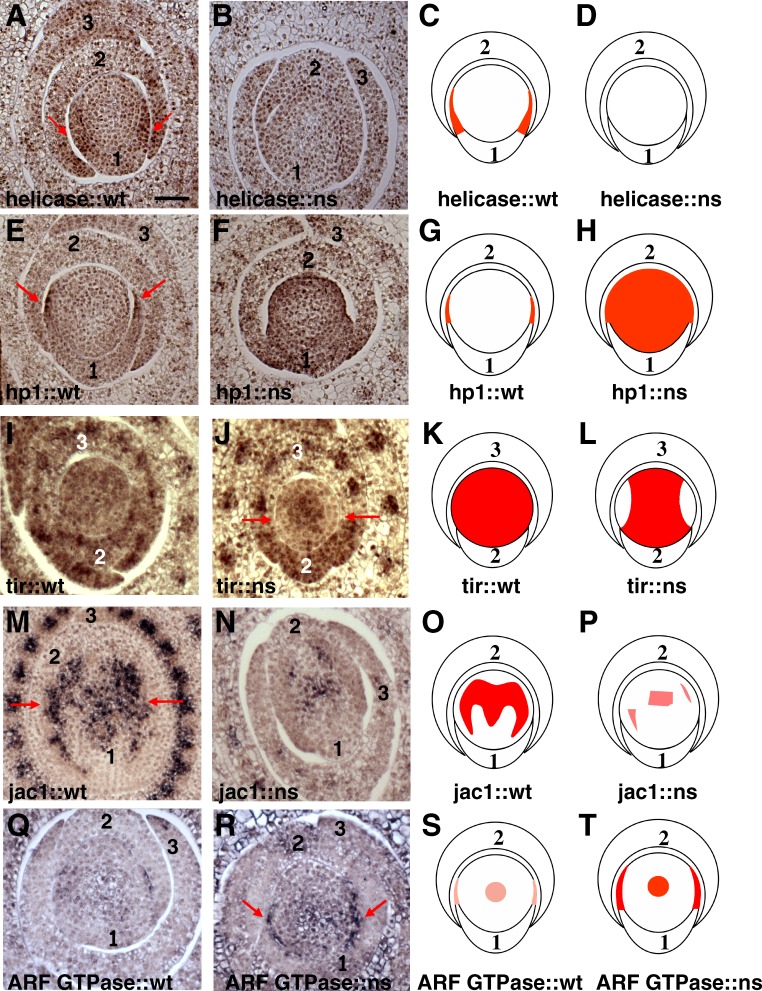
In Situ Hybridization Reveals Domain-Specific Expression of Differentially Expressed Maize Genes in Nonmutant and ns1-R Mutant Shoot Apices, Part I.Drawings of SAM expression patterns are modeled in (C and D), (G and H), (K and L), (O and P), and (S and T). Differentially expressed maize genes shown in nonmutant (wild type: [A], [E], [I], [M], and [Q]) and ns1-R mutant (ns: [B], [F], [J], [N], and [R]) shoot apices. No expression in leaf primordia is portrayed in cartoons, since transcripts accumulating in leaves were not LM sampled or reflected in microarray data. Probes were made from maize ESTs: DV621960 (A and B), CD001847 (E and F), DN210415 (I and J), Zmhp1 (M and N), and DN221438 (Q and R).Predicted functions are abbreviated as: helicase, DEAD BOX HELICASE; hp1, HISTIDINE PHOSPHOTRANSFER PROTEIN1; tir1, TRANSPORT INHIBITOR RESPONSE F-BOX protein; jac1, JACALIN-related LECTIN; and GTPase, Rab class GTP-BINDING SIGNAL TRANSDUCER. Numbers denote leaf primordia. Analyses of expression patterns are provided in the text.